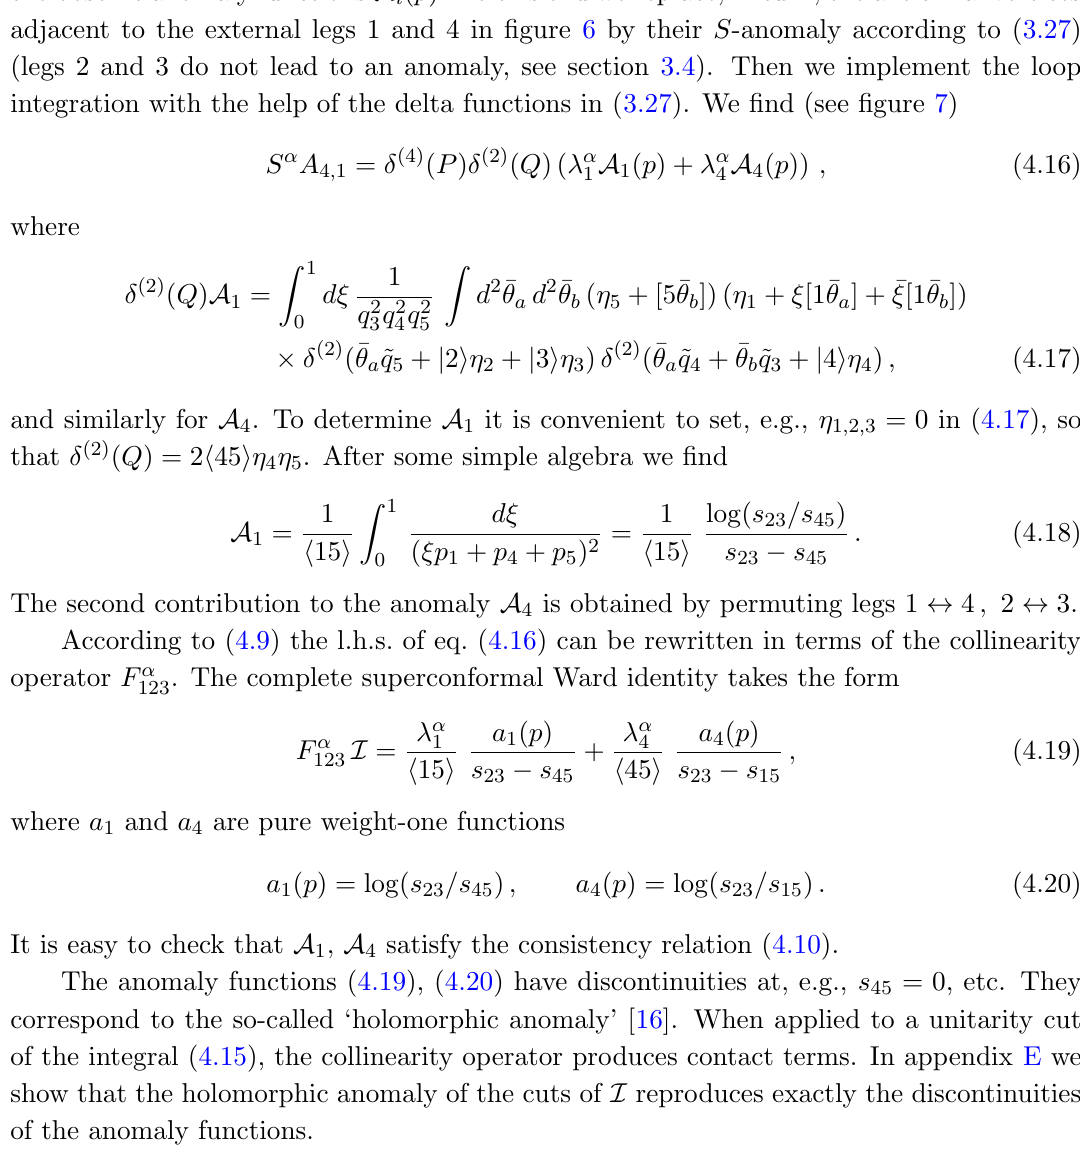
Figure 7 . The S -variation of the supergraph (4.13) contains two contributions: eqs. (4.16) and (4.17). They originate from the S -anomaly of the antichiral vertex (3.27). We omit the (cid:24) -integration in the